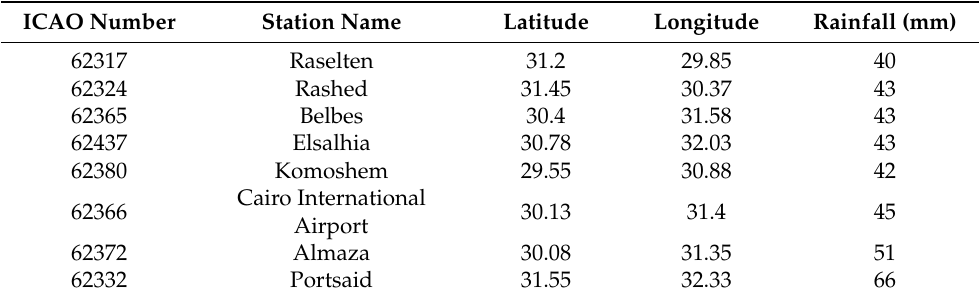
Table 2. Rain gauge stations in Egypt showed accumulated daily rainfall (mm) exceeded 40 mm during the storm on 12 March 2020. (Egyptian Meteorological Authority